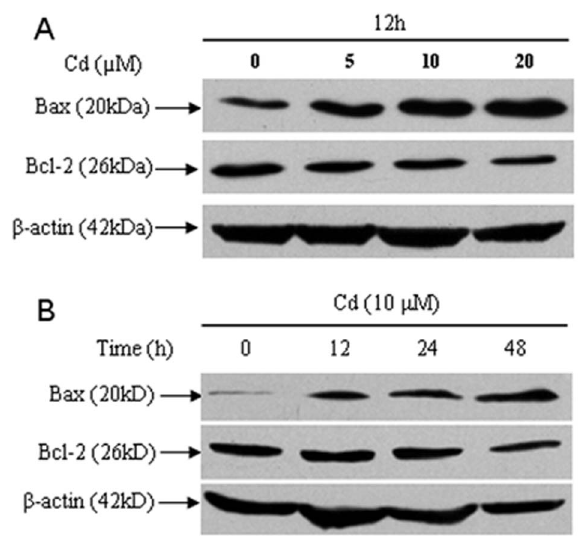
Figure 8. Cd regulated the expression levels of Bcl-2 and Bax. (A and B) Cerebral cortical neurons were treated with Cd (0, 5, 10, 20 m M) for 12 h, or 10 m M Cd for 0–48 h and then assessed by Western blotting. b -actin was used as an internal control. The expression level of Bcl-2 decreased, while that of Bax increased. All experiments were performed twice.